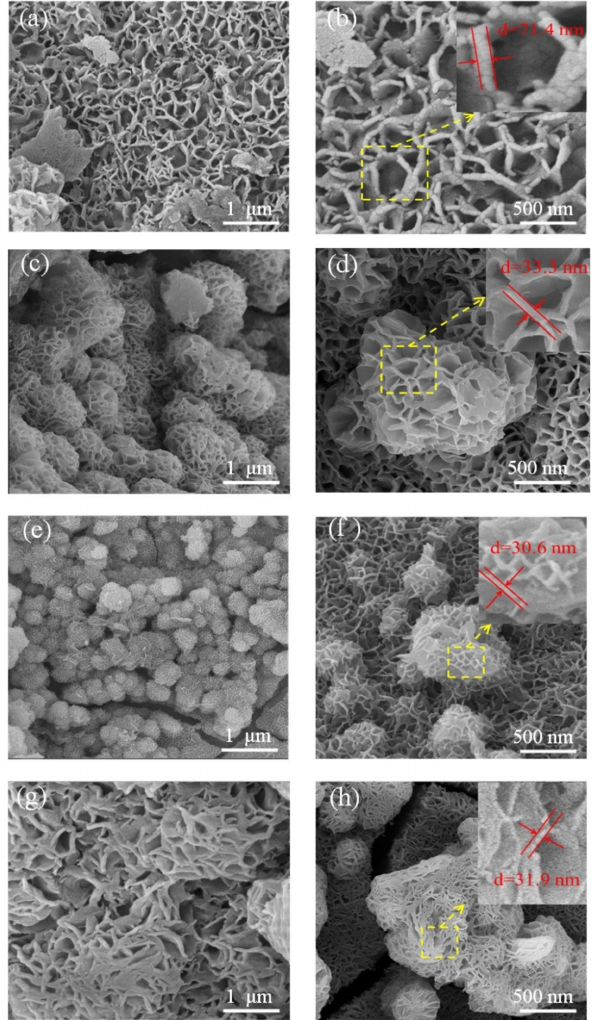
Figure 5. SEM images of as-prepared samples: ( a , b ) NiCo(OH) 4 -NiO-70 at different separation rates, ( c , d ) NiCo(OH) 4 -NiO-90 at different separation rates, ( e , f ) NiCo(OH) 4 -NiO-100 at different separation rates, ( g , h ) NiCo(OH) 4 -NiO-110 at different separation